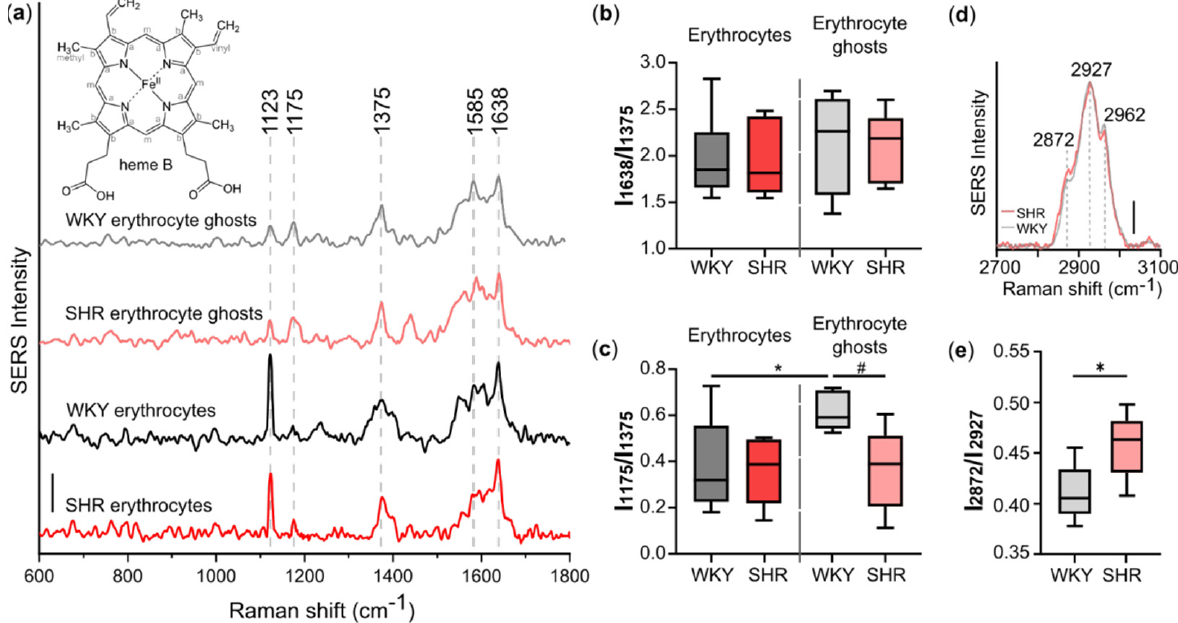
Figure 3. Hypertension-related effects. ( a ) SERS spectra of erythrocyte ghosts and erythrocytes from WKY rats and SHR in the low-frequency region. Spectra are normalized by the intensity of the peak at 1375 cm − 1 . Spectra are shifted vertically for a better presentation. Numbers above peaks correspond to the peak positions (in cm − 1 ). Scale 0.5 a. u. ( b ) The ratio I 1638 /I 1375 (the probability of the planar heme conformation) and ( c ) the ratio I 1175 /I 1375 (in-plane heme mobility) calculated from the SERS spectra of erythrocytes and erythrocyte ghosts from WKY rats (grey boxes) and SHR (red boxes). * p < 0.05; # p = 0.0556 (Mann-Whitney test). ( d ) SERS spectra of erythrocyte ghosts from WKY rats (gray) and SHR (red) in the high-frequency region. Spectra are normalized by the intensity of the peak 2927 cm − 1 . Numbers above peaks correspond to the peak positions (in cm − 1 ). Scale 0.2 a. u. ( e ) The ratio I 2872 /I 2927 reflects the ordering of the lipid phase in the membrane of erythrocyte ghosts. * p < 0.05 (Mann-Whitney test). To investigate the conformational properties of Hb mb heme, we calculated the ratios of the SERS peak intensities: I 1638 /I 1375 and I 1175 /I 1375 (Figure 3b,c). The intensity of the peak at 1375 cm − 1 is used as a normalizing factor, since its intensity does not depend on the heme conformation and can be regarded as a constant value in our experimental conditions. As was demonstrated earlier [30–32], the heme b in Hb predominantly exists in two conformations: planar and domed [30–32]. The first ratio, I 1638 /I 1375 , shows the probability of the planar heme conformation. The higher this ratio is, the higher the probability of a planar conformation of the heme is [33,34]. Moreover, the use of ratios of peak intensities causes the spectral analysis to be independent of the local SERS signal intensity. Our results clearly indicate the absence of the effect of hypertension on the probability of the planar heme conformation (Figure 3b). The ratio of I 1175 /I 1375 peak intensities represents the probability of the asymmetric pyrrole half-ring vibrations and can be used as a marker of heme mobility: the higher this ratio is, the higher the in-plane mobility of the heme is [33,34]. We found that this ratio is more dispersed in erythrocytes than in erythrocyte ghosts (Figure 3c), which may be explained by the more heterogeneous Hb population in the submembrane region of intact erythrocytes than in erythrocyte ghosts (Figure 1b). We observed no differences in the I 1175 /I 1375 ratio in the SERS spectra of erythrocytes from normotensive and hypertensive rats (Figure 3c). In contrast, we observed a significant decrease in this ratio for erythrocyte ghosts from SHR rats, indicating the decreased in-plane mobility of the heme in Hb mb (Figure 3c). Moreover, this marker negatively correlates with ABP (Figure 4).